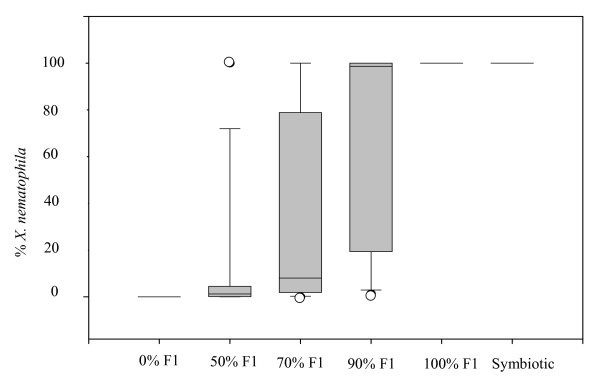
Percentile distribution of the percentages of X. nematophila within Xenorhabdus sp. found in the hemolymph of the insects 48 h post-infection. Results are given as box plots, where the horizontal line indicate the median (50th of the data), the bottom and the top of the box indicate the first quartiles (25th of the data) and the third quartiles (75th of the data). The whiskers the range of the data (10th of the data and 90th of the data). Others dots are outliers which are under the 10th percentile of the data or over 90th percentile of the data. The abscissa shows the condition of the initial infection.